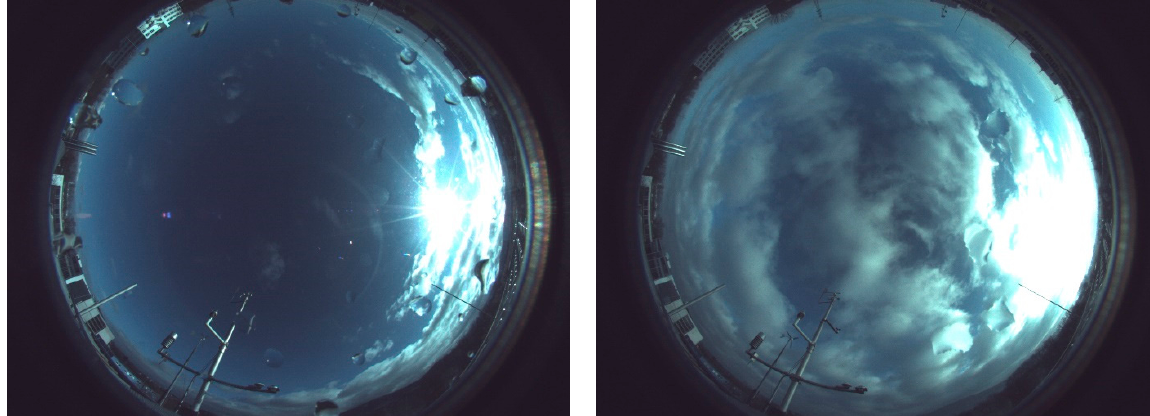
Figure 5. Examples of the removed images with many raindrops upon the lens, dirt on the lens, a closed cloud cover, and heavy fog.